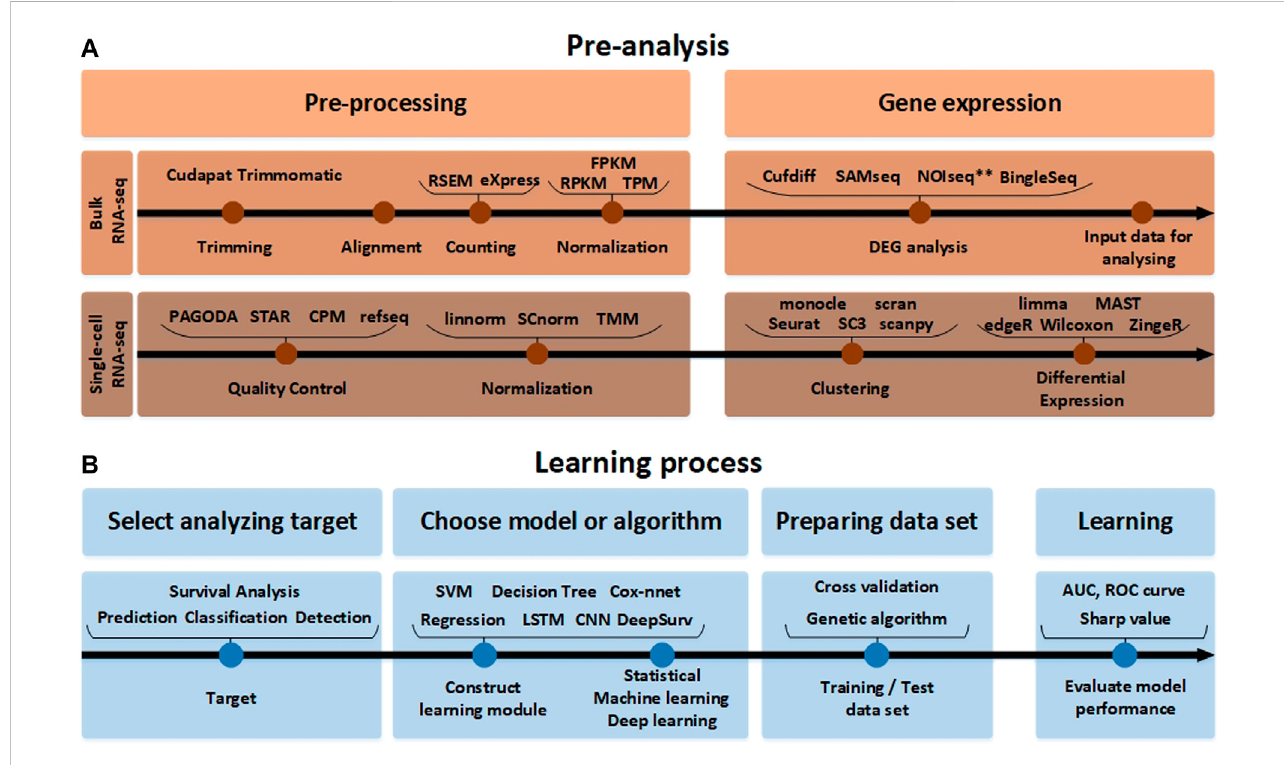
FIGURE 2 TheRNA-seqdataanalysisprocess. (A) BeforetheanalysisofRNA-seqdata.Thepre-analysispartincludestheconversionprocesstoformtheinputdata intoanappropriateformatthatcanhelpinanalyzingtheRNA-seqdata.Sincethedetailed toolsusedforprocessing andgeneexpression analysis aredifferent in single-cell RNA-seq and bulk RNA-seq analysis methods, they are indicated separately. (B) The learning process part after the analysis of RNA-seq data.